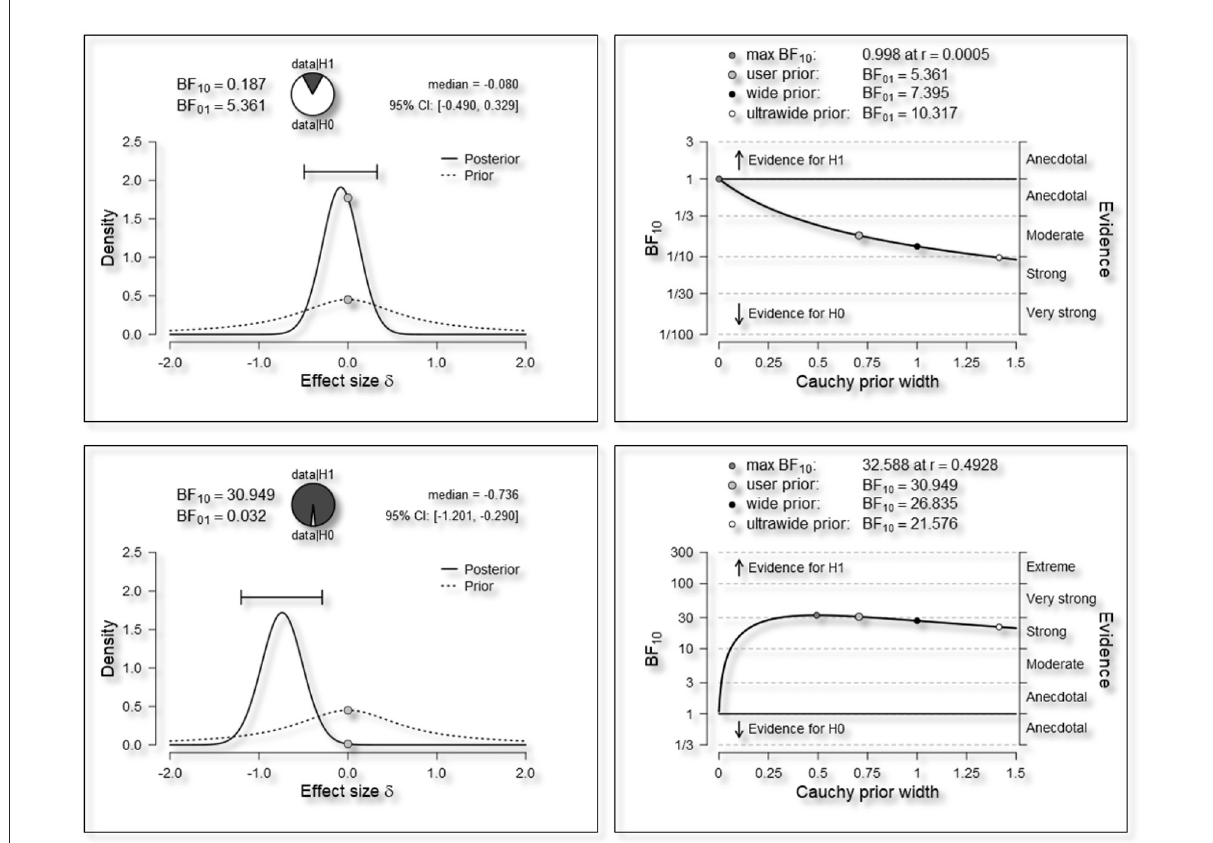
FIGURE4 Example test information and robustness analysis plots. Top-left (A) —Prior and posterior mass plots Action: addition, Top-right (B) —Robustness analysis Action: addition, Bottom-left (C) —Prior and posterior mass plots Score: total, Bottom-right (D) —Robustness analysis Score: